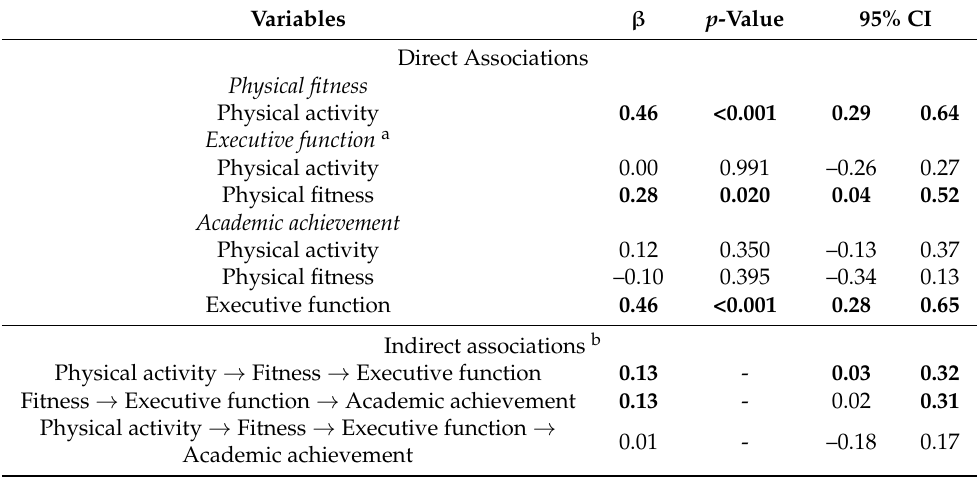
Table 2. Standardised direct and indirect association coefficients of the final model.